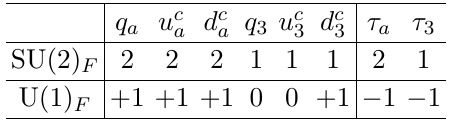
Table 1 . Multiplets and transformation properties of the supersymmetric model in refs. [53– 55], ( a = 1 , 2)